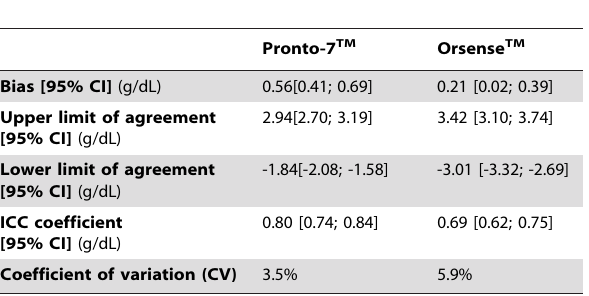
Table 2. Concordance parameters of the two methods.